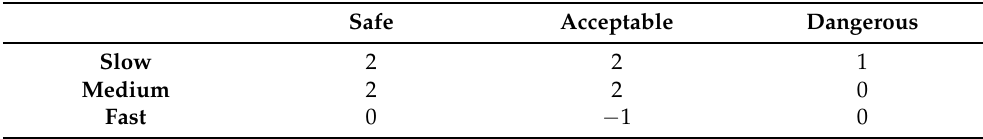
Figure 8. The sets of the consequent; 0: high deceleration; 1: low acceleration; 2: high acceleration. Table 1. Table of control actions for each pair of